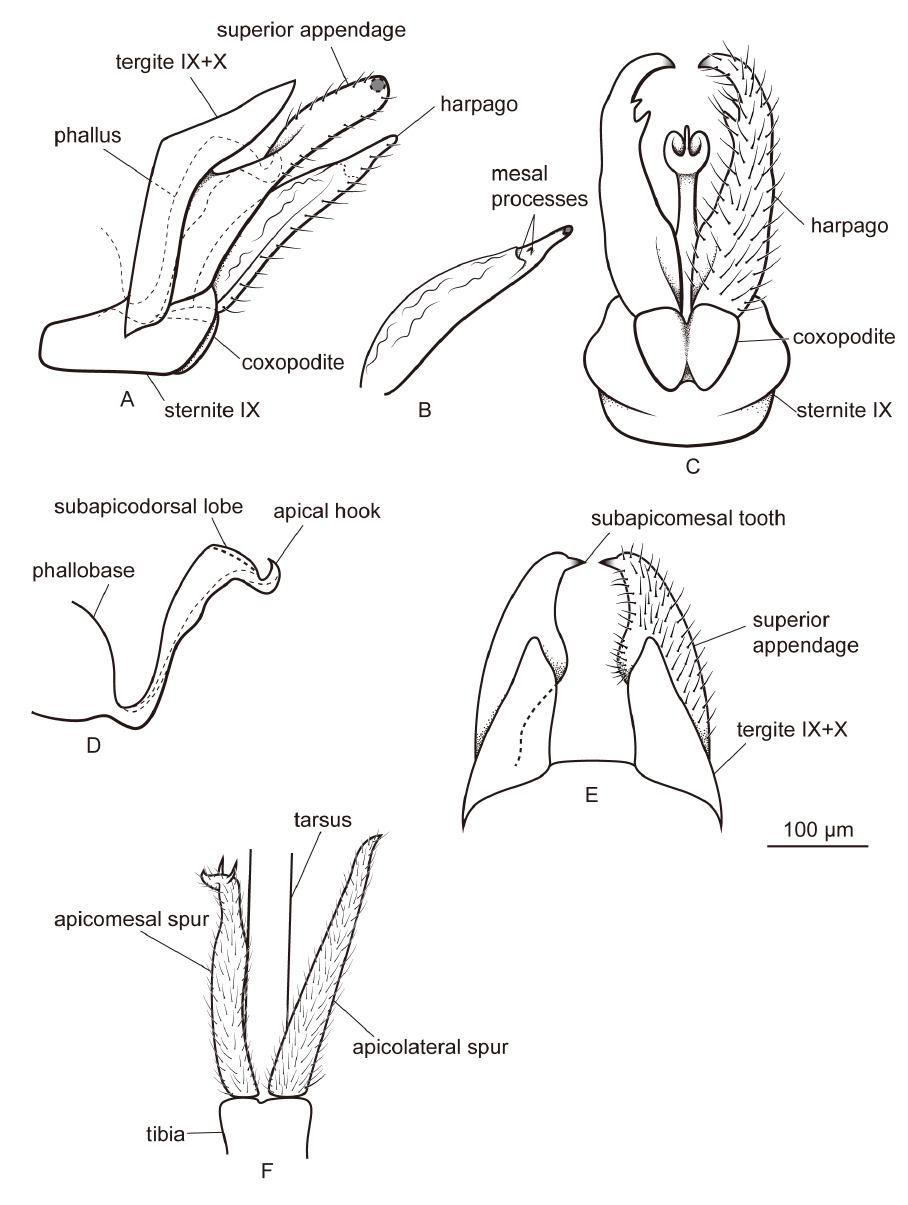
Figure 3. Male of Metalype shexianensis sp. n. A genitalia, left lateral B right harpago, mesal C genitalia, ventral D phallus, left lateral E genitalia, dorsal F apical spurs of right hind leg, ventral. Description. Male. Forewings each 3.8–3.9 mm (n = 2). Compound eyes black, body yellow. Apicomesal spur of each hind tibia curved laterad and twisted apically, with two small subapical